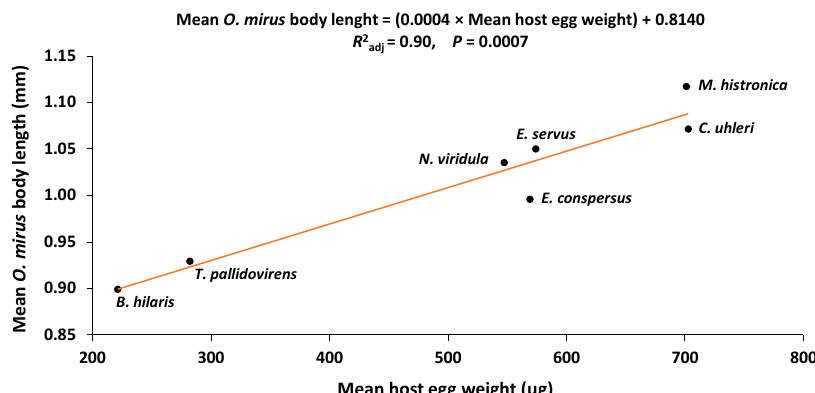
Figure 4. Linear relationship between mean Ooencyrtus mirus body length and the respective mean host egg